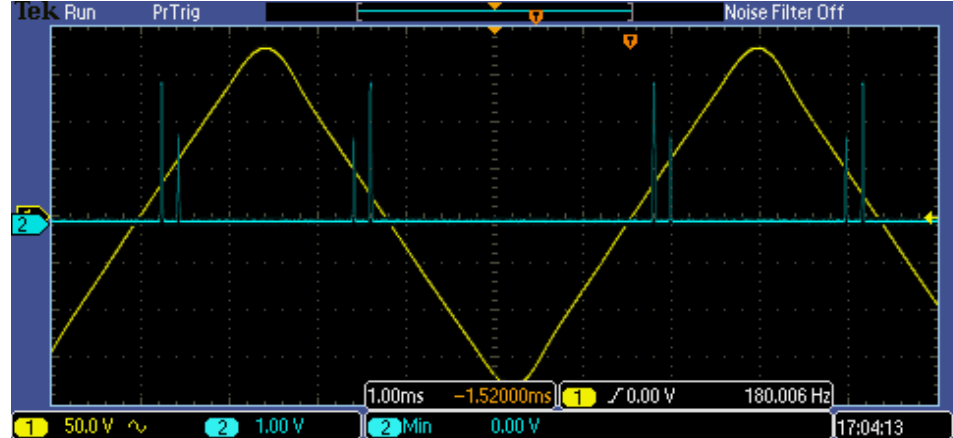
Figure 11. Acquired signal (light blue signal) while measuring a transparent film, together with the smoothed triangular modulating wave (yellow signal). Amplitude scale: 50 V/division for triangular wave; 1 V/division for acquired signal. Horizontal scale: 1 ms/division.